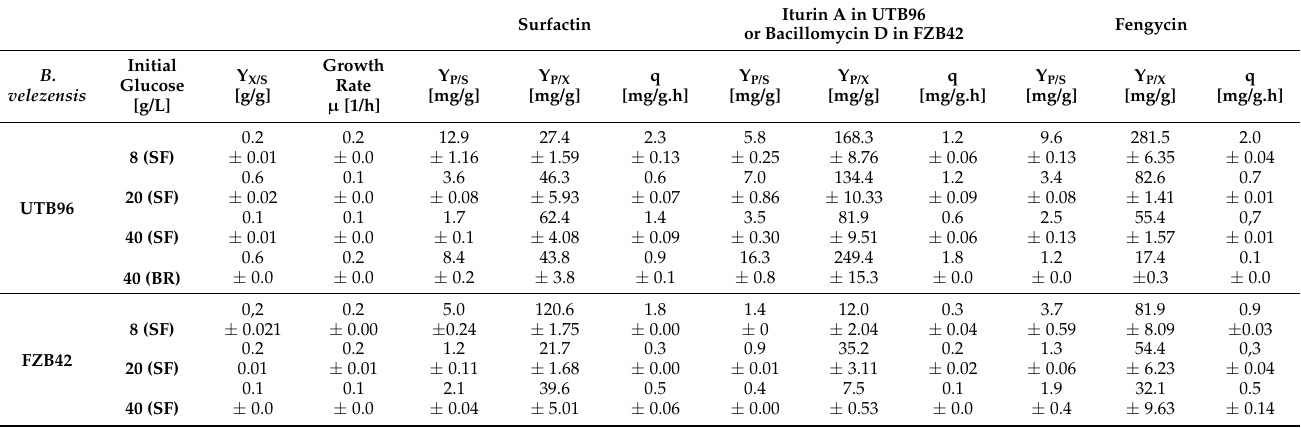
Table 2. Overview of the lipopeptide production parameters including surfactin, iturin A or bacil- lomycin D and fengycin by B. velezensis UTB96 and B. velezensis FZB42 and in shake flask cultivations with initial glucose concentrations of 8 g/L, 20 g/L and 40 g/L and in a batch bioreactor using 40 g/L of glucose. Surfactin Iturin A in UTB96 or Bacillomycin D in